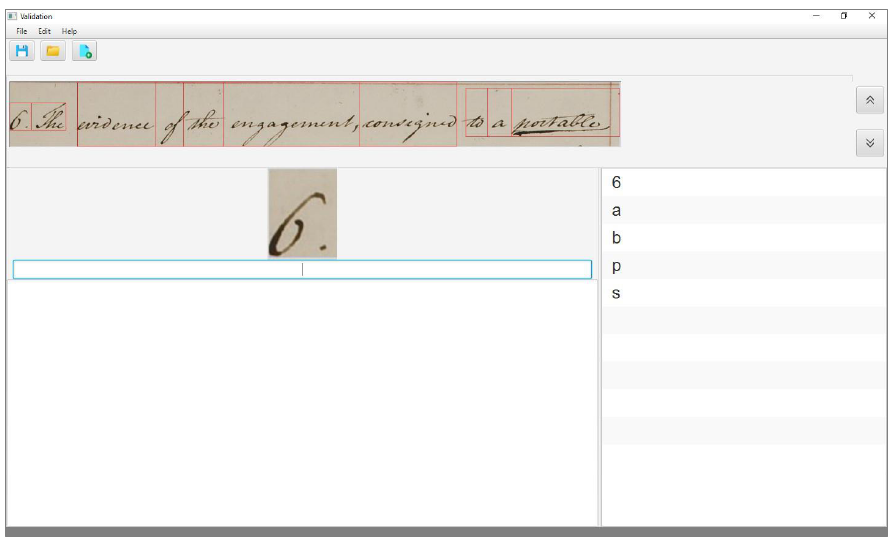
Figure 1. The user interface of the validation tool.